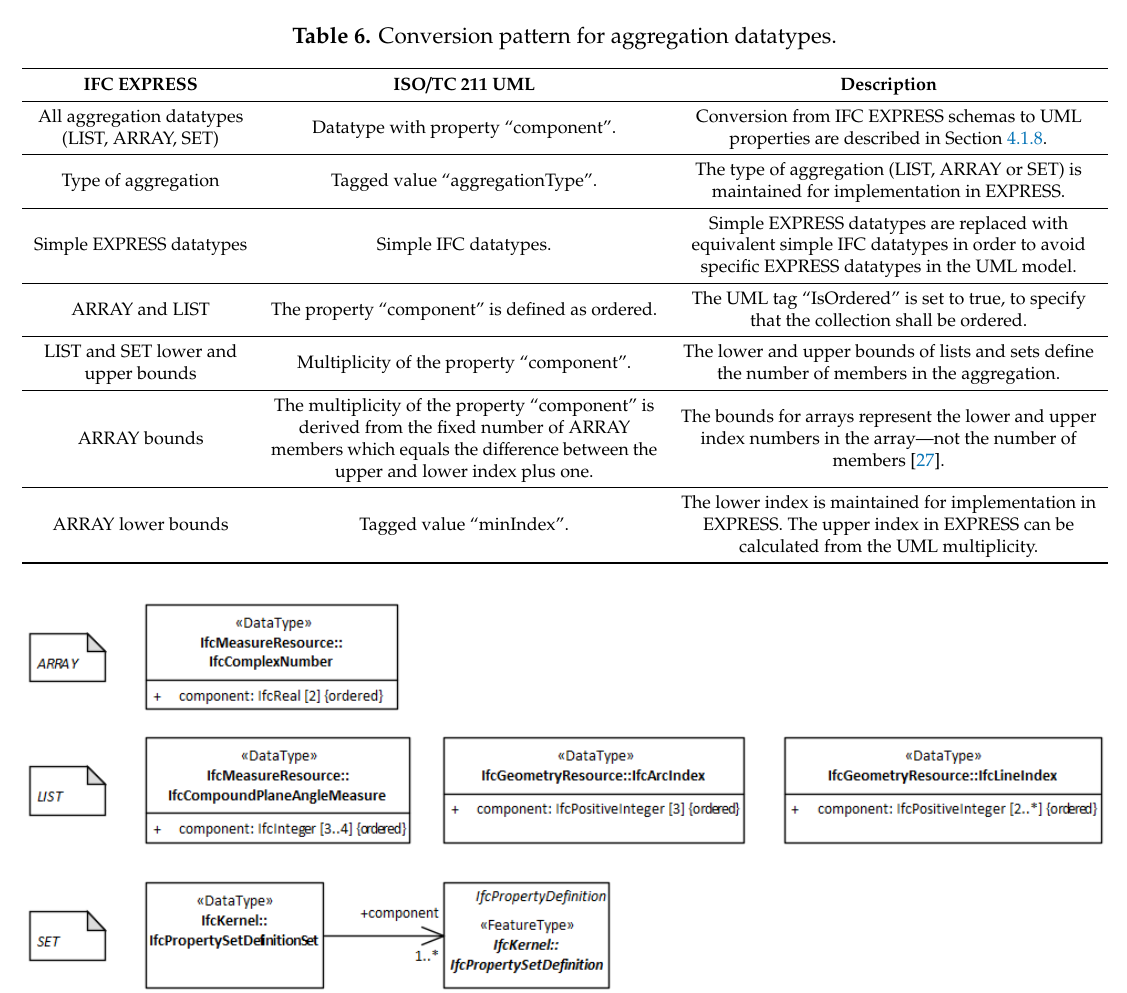
Figure 5. UML class diagram showing IFC aggregation datatypes in UML.